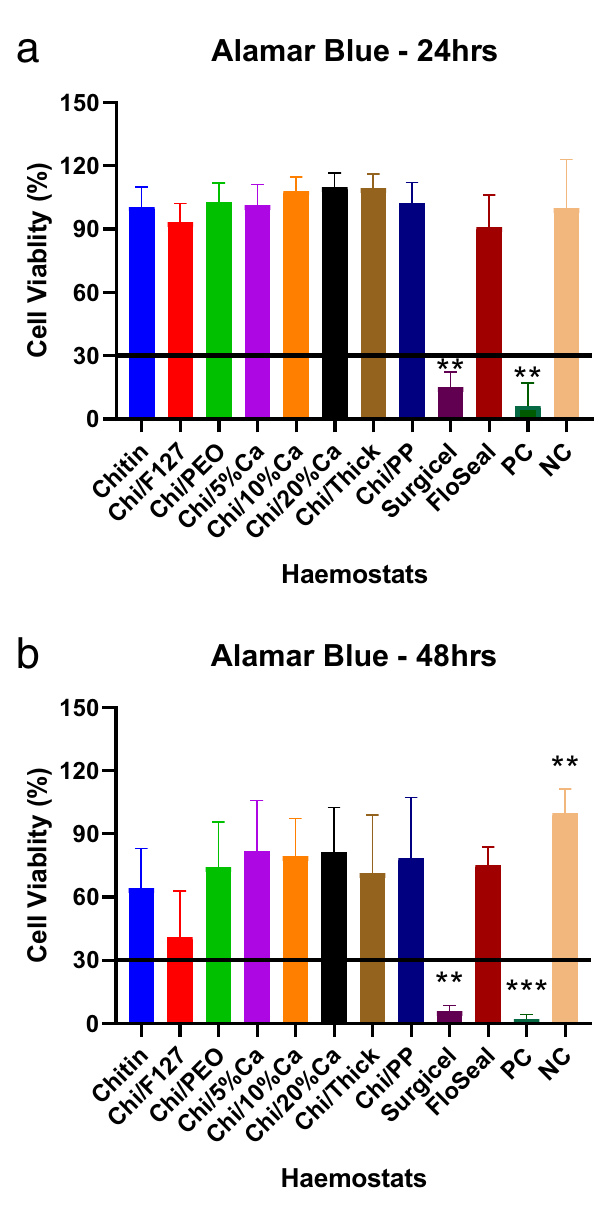
Figure 12. The cytotoxic effects of modified and non-modified beta-chitin patches, Surgicel and FloSeal on PC-12 cells as measured by AlamarBlue ( a , b ). AlamarBlue assay at ( a ) 24-h and ( b ) 48-h post-treatment, showing the cell viability with non-modified beta-chitin patch (Chitin), Chi/F127, Chi/PEO, Chi/5%Ca, Chi/10%Ca, Chi/20%Ca, Chi/Thick, Chi/PP, Surgicel, FloSeal and PC (10% Triton-X100 in PBS) treatments, normalised to NC (culture media). *p < 0.05 and **p < 0.001, compared to non-modified beta-chitin patch, analysed by Kruskal–Wallis one-way ANOVA with Dunn’s test, n =